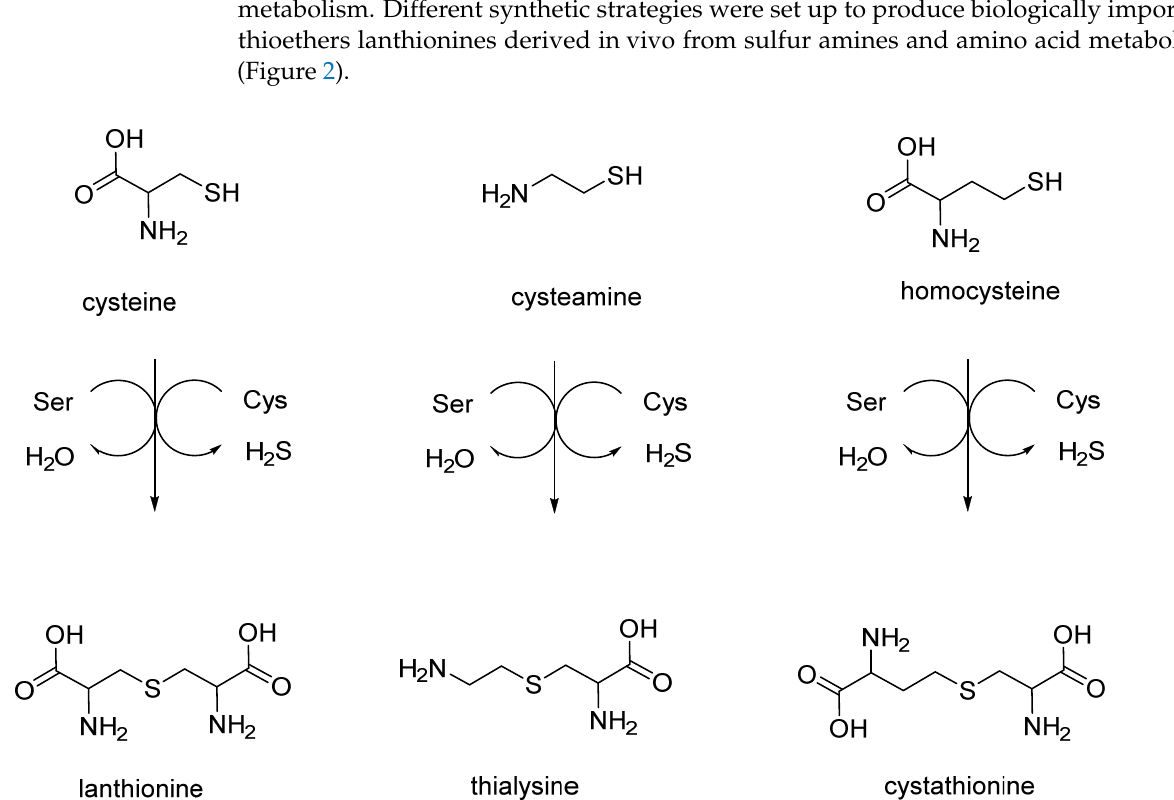
Figure 2. In vivo production of lanthionines catalyzed by cystathionine beta synthase enzyme (CBS), starting from biological active amines and amino acids.